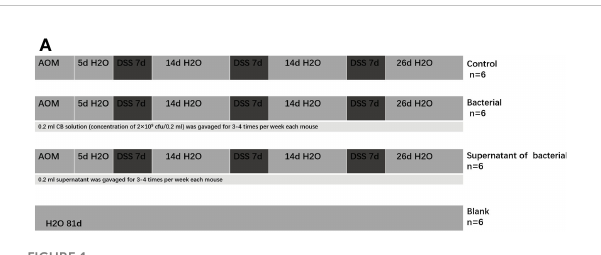
FIGURE 1 The mice models of CRC were induced by AOM+DSS and gavaged of CB culture and supernatant as